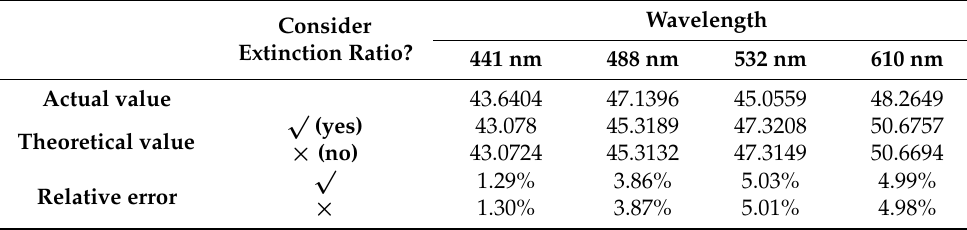
Table 3. The SNR and relative error of each wavelength (with or without extinction ratio).